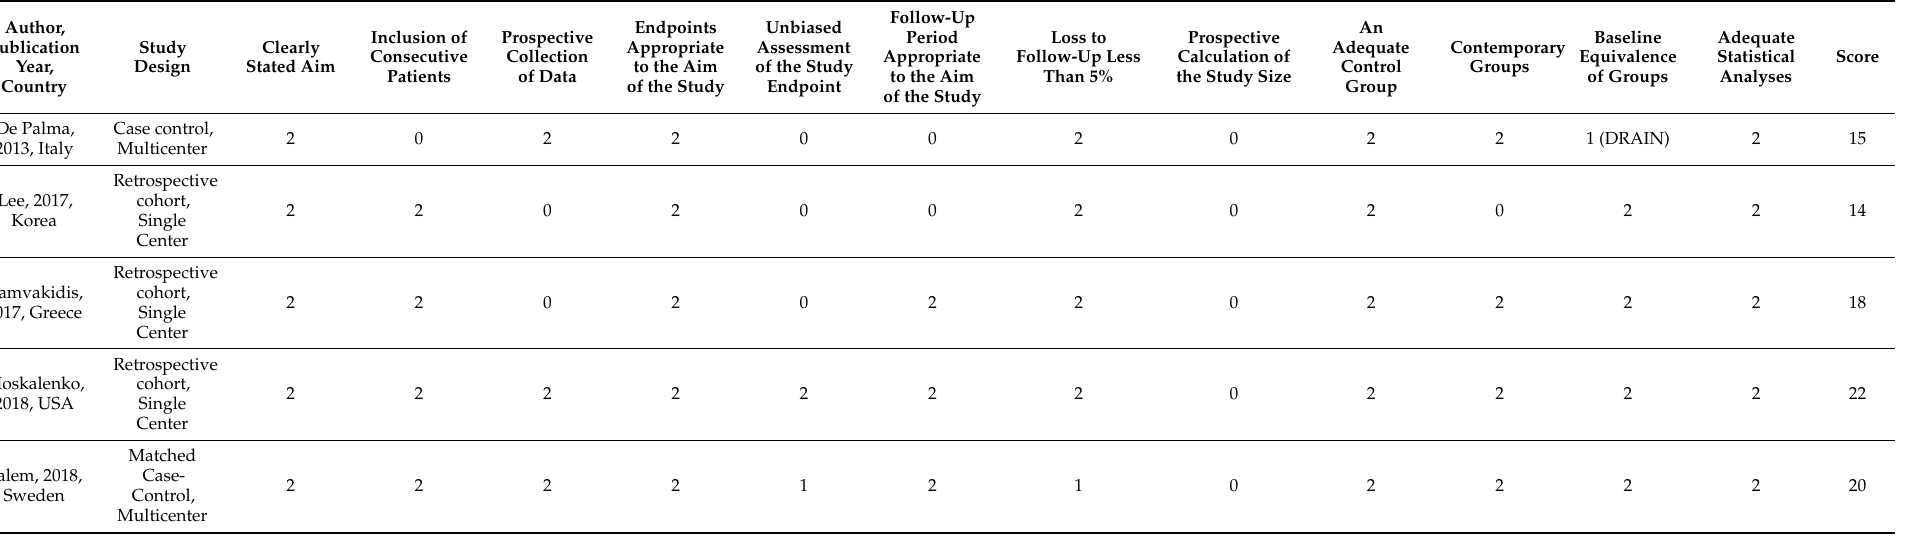
Table 3. Minors scores for comparative